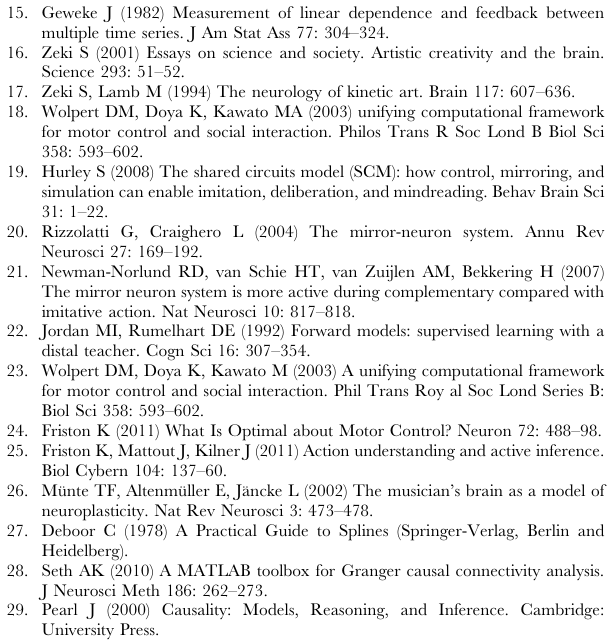
Figure S1 Factor loadings for the subjective question- naire items. X and Y axes show loading on the two factors extracted with factor analysis. Q1 to Q8 represent loadings on the two factors for each of the eight questions. (EPS) Methods S1 Additional details on the application of Granger causality method as well as more details on the analyses and